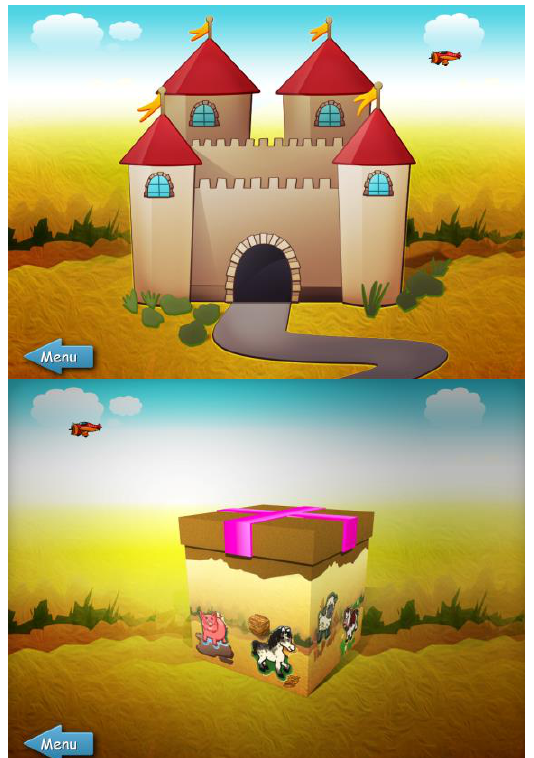
Figure 5. Waiting for the identity card (Up) / Waiting for the “Farm Box” (Down)